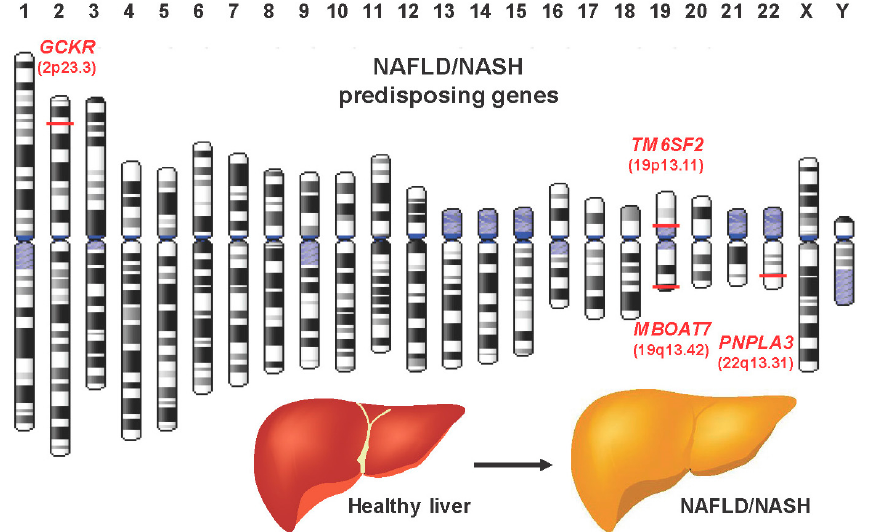
Figure 4. Gene alterations in NASH. Gene alterations/modifications associated with the pathogenesis of NASH affect the GCKR , TM6SF2 , PNPLA3 , and MBOAT7 genes. The chromosomal location of respective genes is depicted in the ideogram. Gene annotations were done with the Genome Decoration Page (https://www.ncbi.nlm.nih.gov/genome/tools/gdp) and genomic coordinates deposited in the Online Mendelian Inheritance in Man (OMIM) database under accession no. 609567 ( PNPLA3 , 22q13.31), 606563 ( TM6SF2 , 19p13.11), 606048 ( MBOAT7 , 19q13.42), and 600842 ( GCKR , 2p23.3).